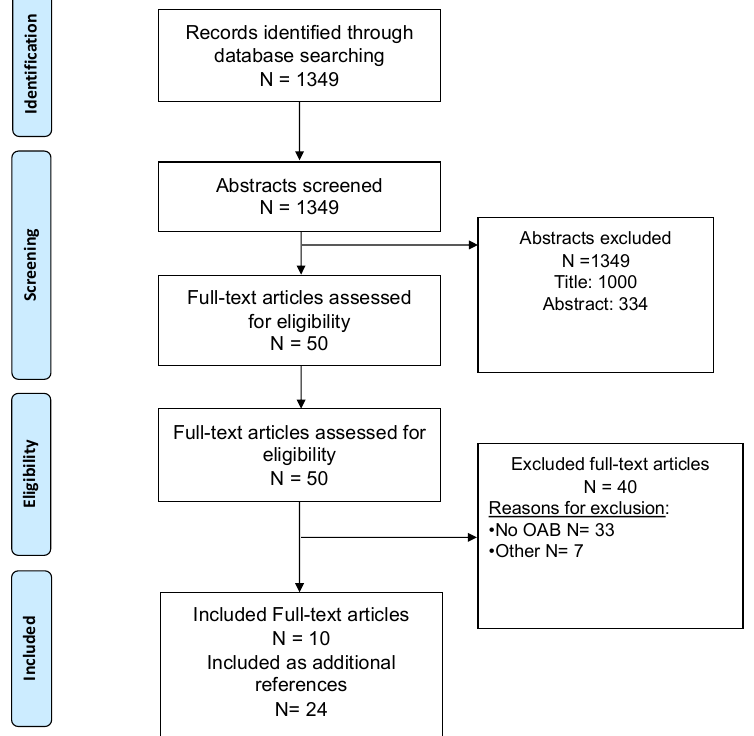
Figure 1. Preferred Reporting Items for Systematic Reviews and Meta-Analyses (PRISMA) Flow diagram of studies identified, excluded and included.